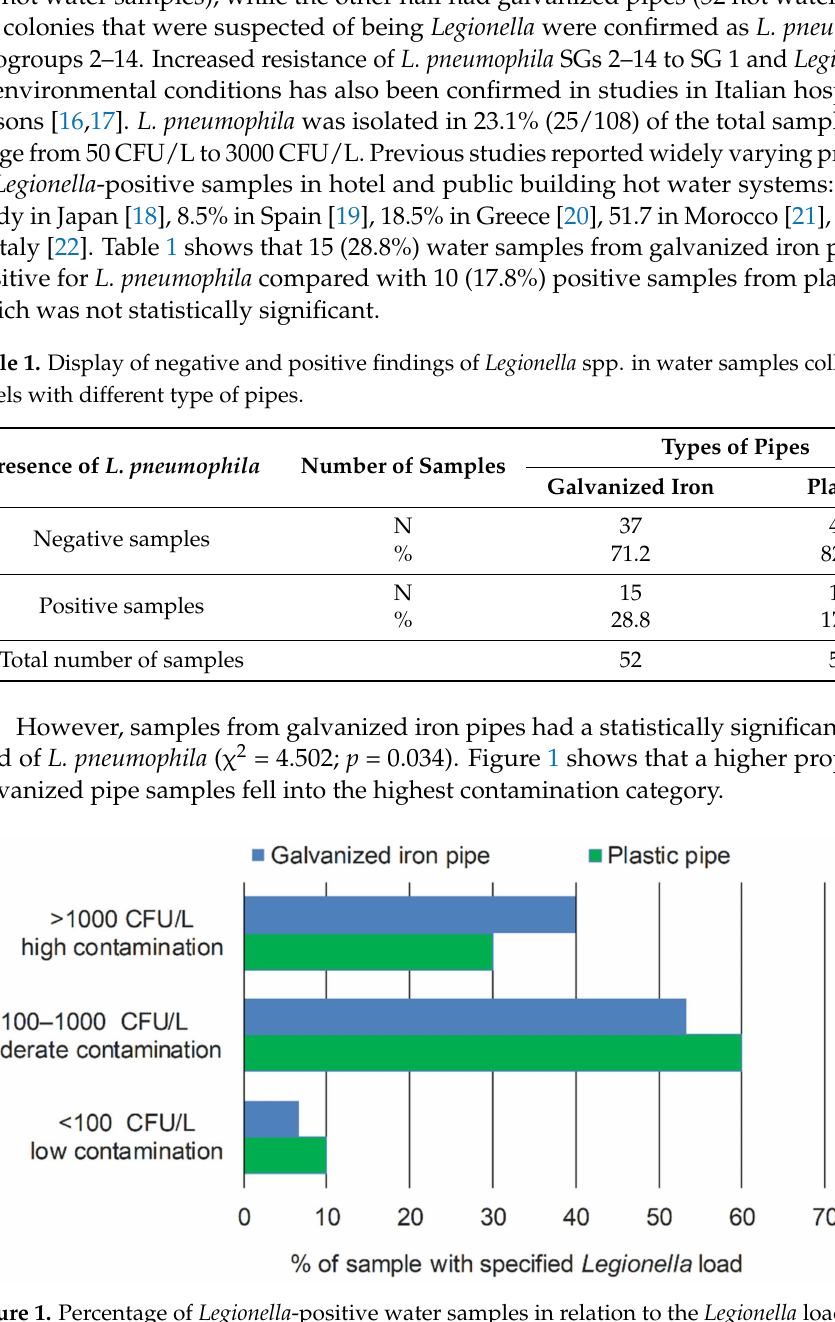
Figure 1. Percentage of Legionella -positive water samples in relation to the Legionella load for galva- nized pipe and plastic (PVC)